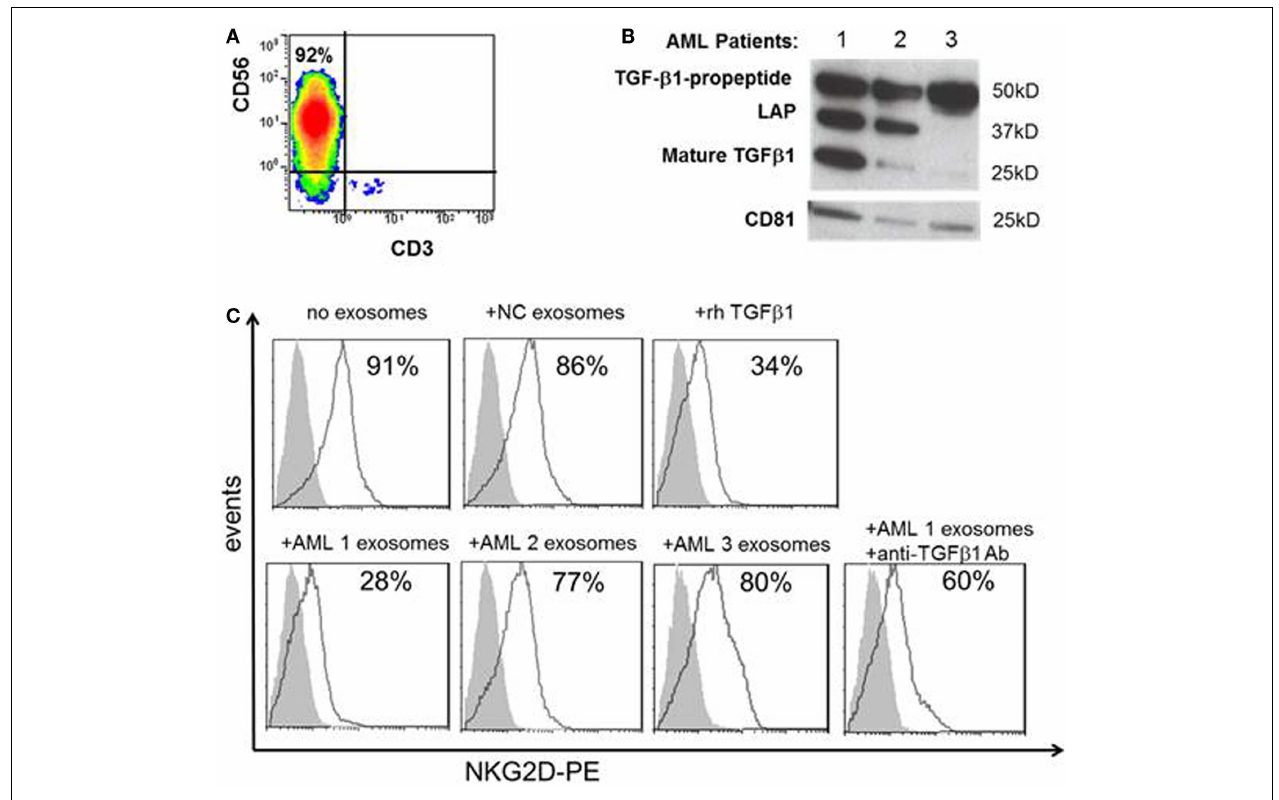
Methods.” NKG2D expression (in MFI) was found to be down-regulated only with exosomes of patient #1 and rhTGF- β 1. Exosomes isolated from a NC had no effect on NKG2D expression on NK cells. Anti-TGF- β 1 Ab protected NK cells from NKG2D down-regulation by exosomes of patient #1. Shown is a representative experiment of three performed with NK cells obtained from different donors.The shaded peaks represent isotype